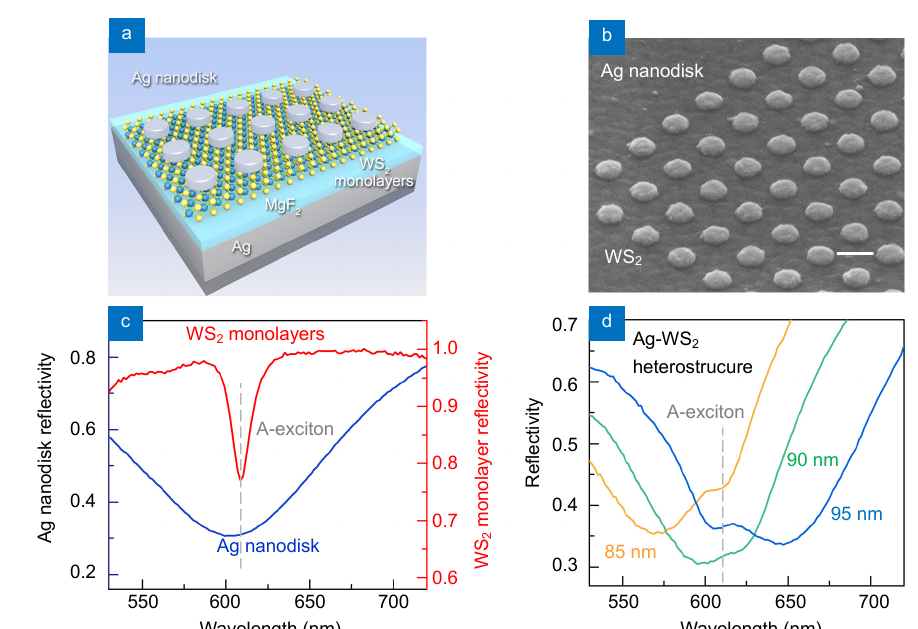
Fig. 1 | Characterization of the Ag-WS 2 heterostructure. ( a ) Schematic of the Ag-WS 2 heterostructure, where Ag nanodisks were fabricated on WS 2 monolayers by EBL. The resonance wavelength of the Ag disk is designed to be resonant with the A-exciton in WS 2 monolayers. ( b ) SEM image of the Ag-WS 2 heterostructure. The diameter of Ag disk is 90 nm. Scale bar: 150 nm. ( c ) Normalized reflectivity spectra of pure WS 2 mono- layers (red line) and bare Ag nanodisks (blue line). The reflectivity spectrum of WS 2 monolayers displays a deep dip at ~610 nm, which is consist with the plasmon resonance of Ag nanodisk with diameter of 90 nm. ( d ) Reflectivity spectra of the Ag-WS 2 heterostructure with the diameter of Ag nanodisk increased from 85 to 95